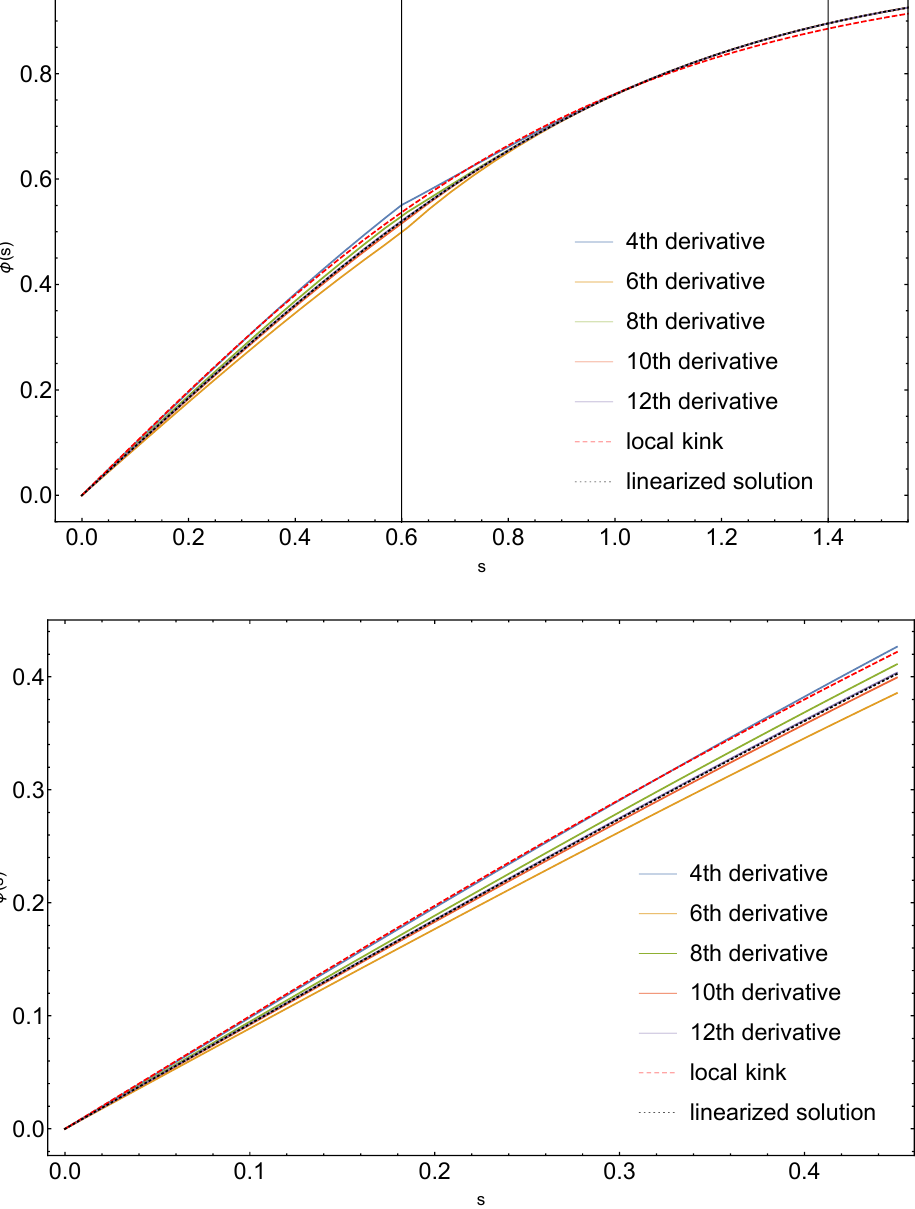
Figure 5 . (Top panel) We have reported the behavior of the full glued solution for several higher- derivative truncation of the differential equation in region 2. We performed computations up to 22 nd order derivative, but it is enough to show the results up to 12 th order. The solutions were obtained by imposing the junction conditions at s = 0 . 6 and s = 1 . 4 (vertical lines) following the procedure explained in this appendix. The 4 , 6 , 8 , 10 , and 12 -th order cases are plotted in comparison with the linearized solution φ = φ + δφ obtained in eq. (4.23) and the local kink solution. The color L and the style for each curve is summarized in the legend. (Bottom panel) we have zoomed on a shorter interval of the x -axis in proximity of the origin in order to see more clearly the differences between the curves. In both panels we set λ = 2 , v = 1 and M 2 = 14 . 3 , which are consistent with s the theoretical constraint M 2 ≥ − λv 2 /W 0 ( − 1 / 3 e ) in eq. s